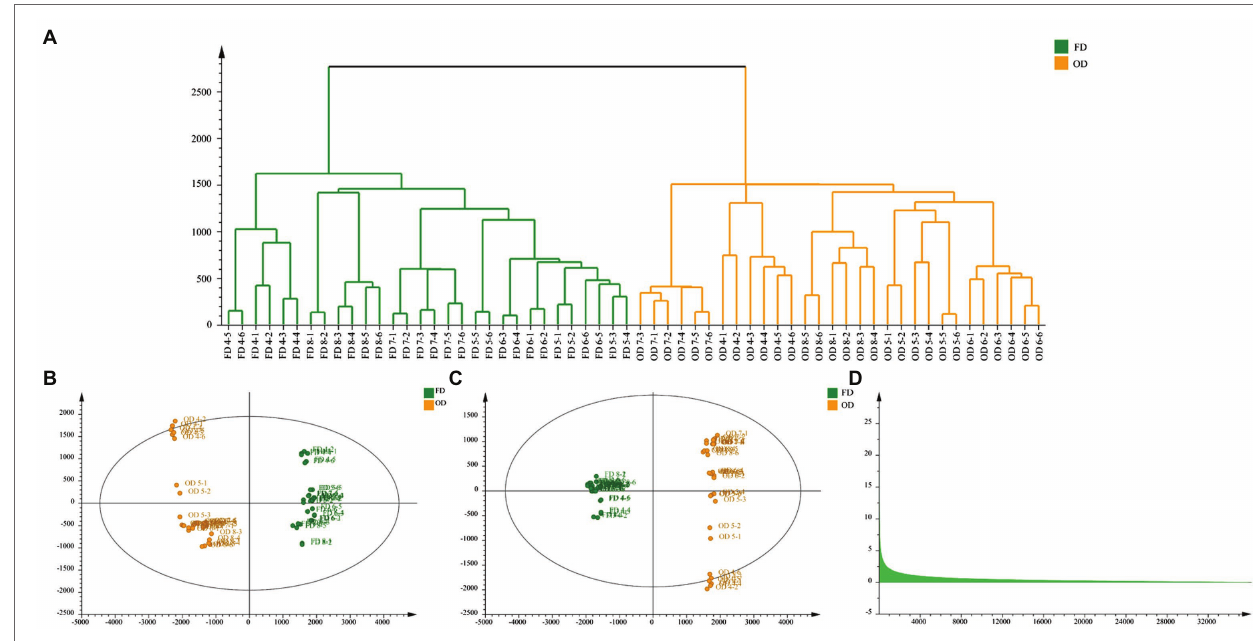
FIGURE 10 | Effects of different drying methods on CWT ( A : cluster analysis, B : principal component analysis, C : orthogonal partial least squares discriminant analysis, D : VIP).